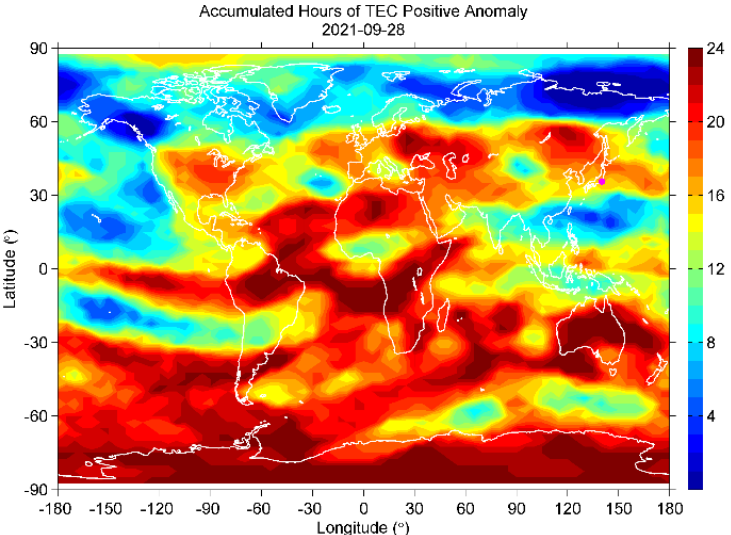
Figure 19. The accumulated hours (max = 24) of TEC positive anomaly on 28 September.